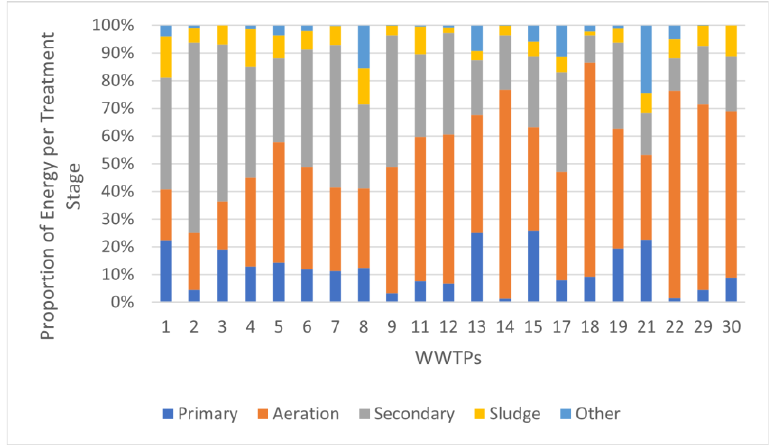
Figure 5. Energy Consumption by WWTP treatment phase.